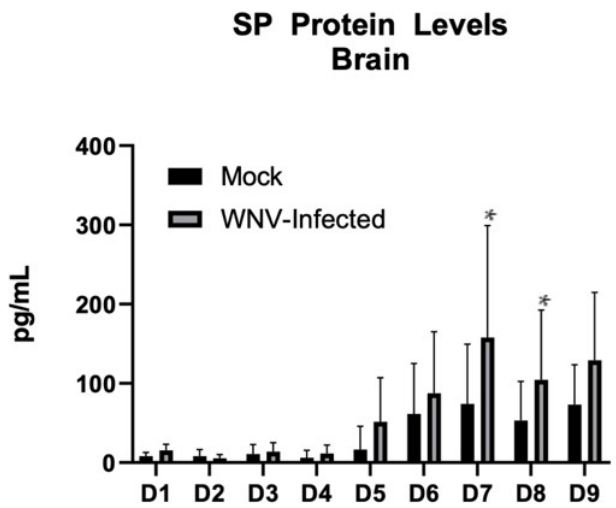
Figure 2. SP as detected by ELISA against a standard curve in whole brain homogenate. Error bars represent the standard deviations. Significantly higher mean protein levels were detected in WNV-infected mice when compared to mock at both 7 DPI ( p = 0.017) and 8 DPI ( p = 0.047). N = 10 per group per day, and N = 18 WNV-infected mice are included in the analyses of D6 and D7 due to early attrition. *: p < 0.05.